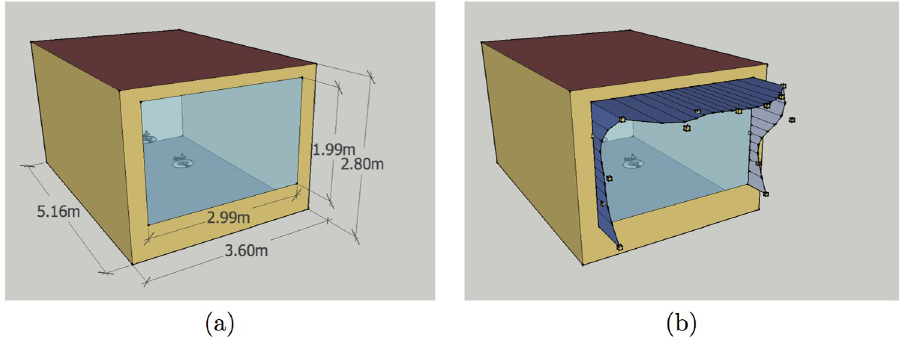
Fig 1. Cellular office model used in simulations: (a) dimensions; (b) small boxes indicate positions of 15 control points of NURBS